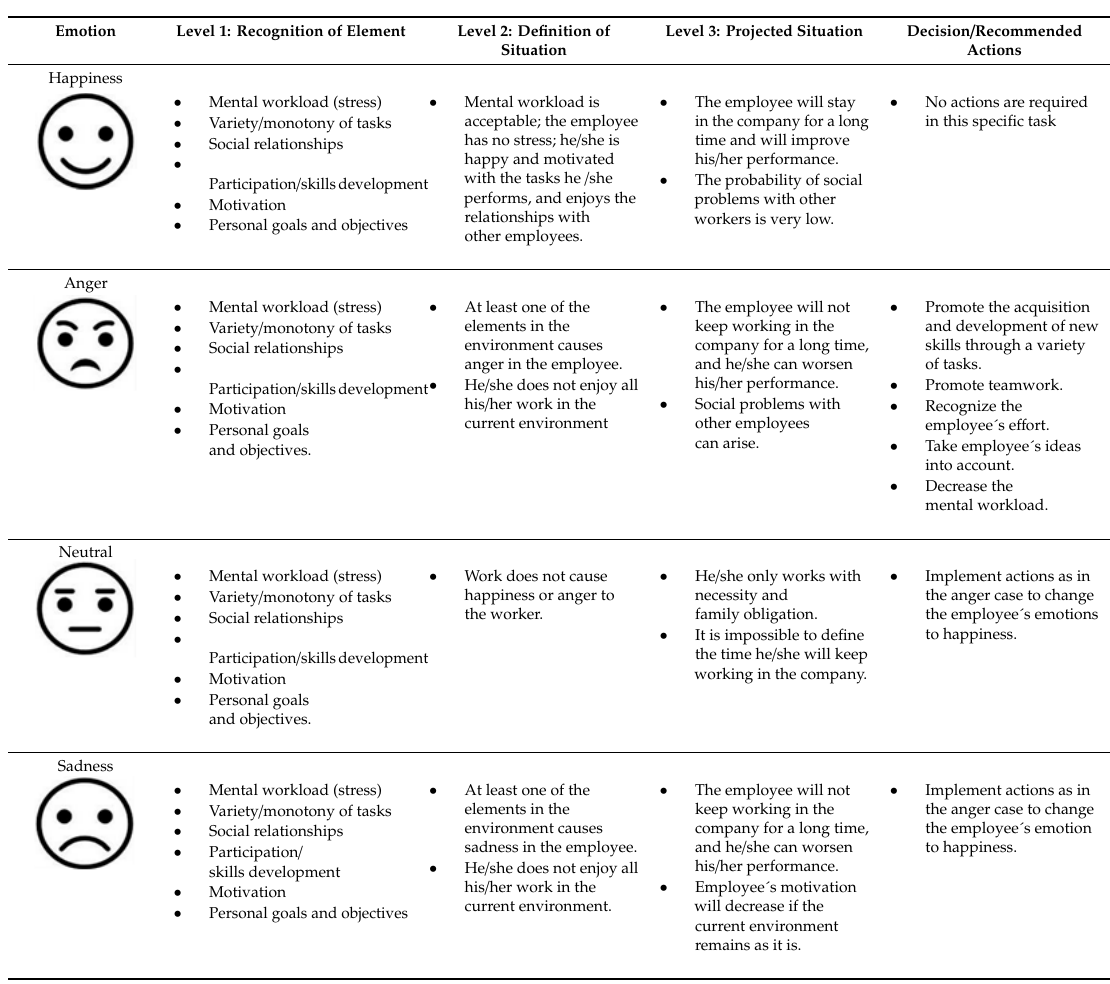
satisfaction, performance, and